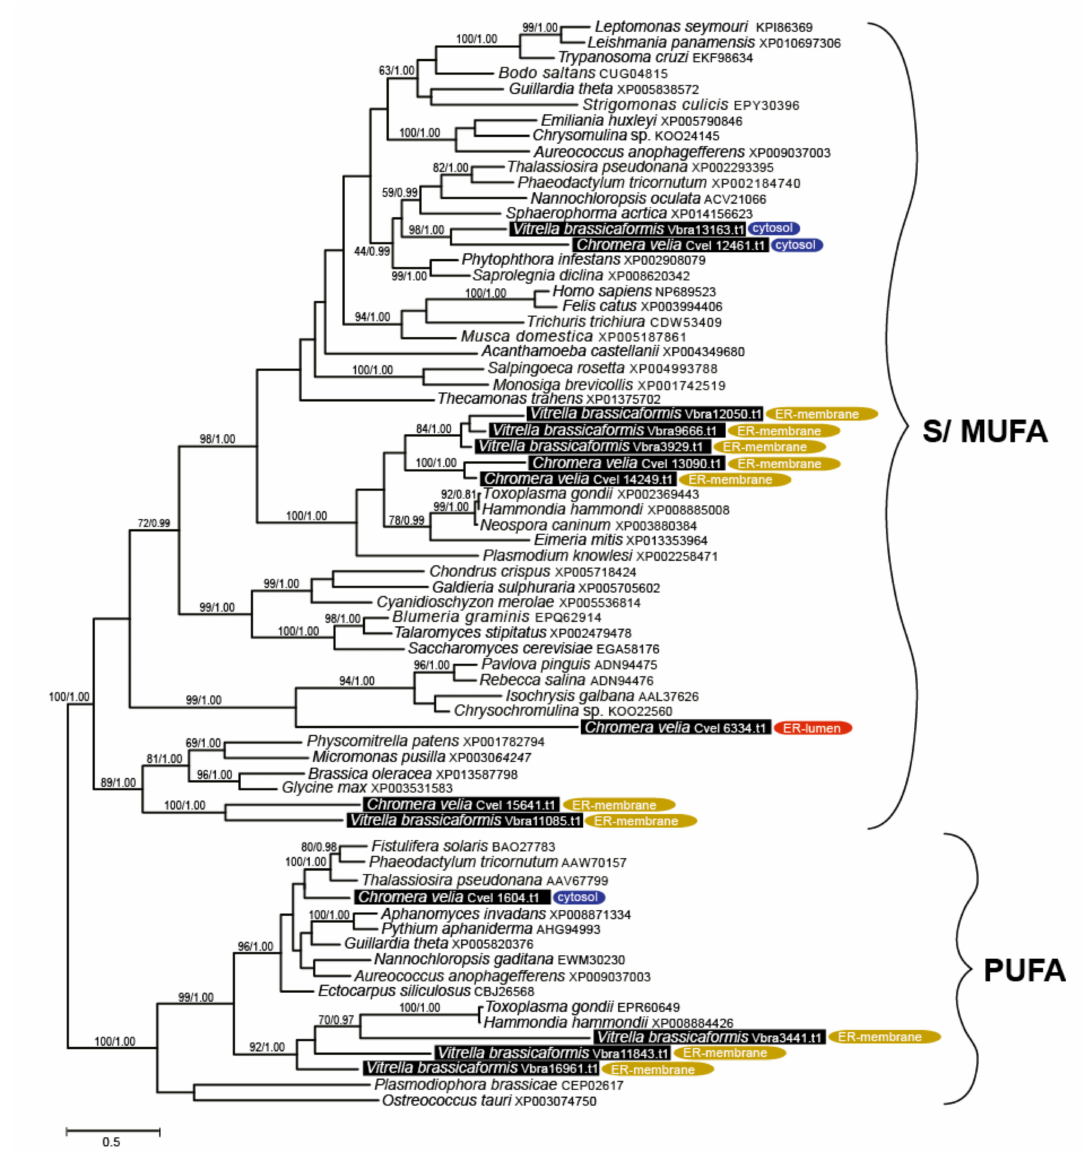
Figure 6. Bayesian phylogenetic tree inferred from elongase domains (70 taxa, 188 amino acid residues). Numbers above the branches display ML bootstrap / Bayesian PP support (BS1000 / 3M, CAT / LG). Predicted subcellular locations are